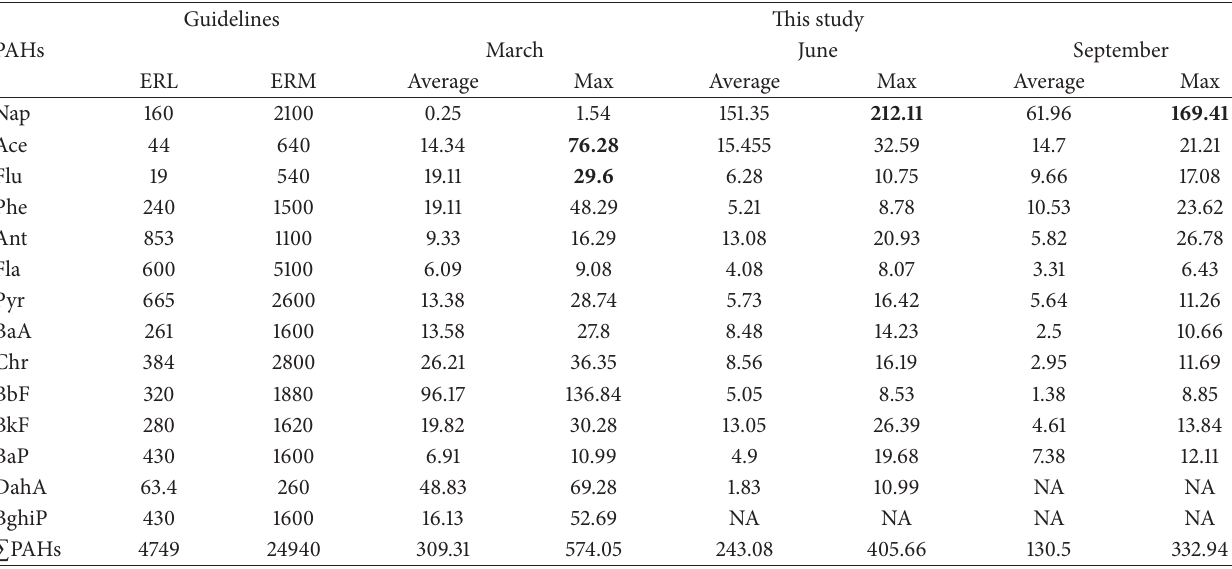
Table 5: Standard pollution criteria of PAH concentrations for sediment (ng/g dw) (ERL: effects range-low, ERM: effects range-median, and NA: not